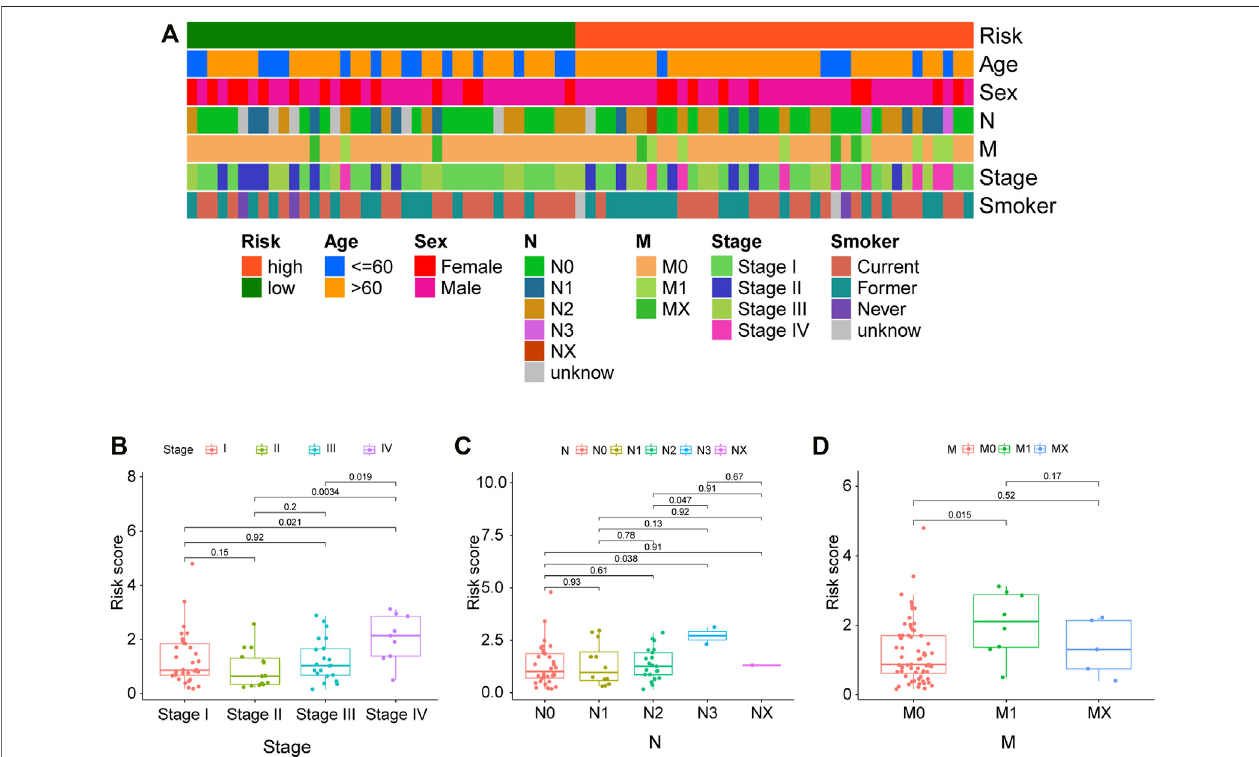
FIGURE 6 | Correlations between clinical characteristics and risk score in the cBioPortal cohort. (A) The correlations between various clinical characteristics and risk score. Correlation coef fi cient and p values were determined by the Spearman rank correlation test. p < 0.001 = ppp , p < 0.01 = pp , and p < 0.05 = p . (B – D) Correlations between the risk score and different tumor stages, N stage, and M stage.